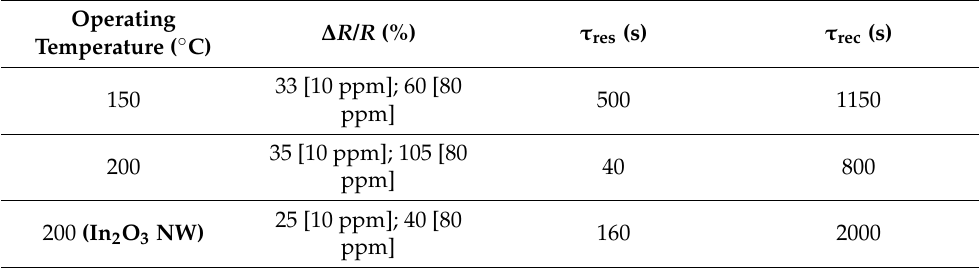
Table 2. Measured response and characteristic response and recovery times of a sensor based on a single (Ga x In 1-x ) 2 O 3 NW from Sample A, operating at temperatures of 150 and 200 ◦ C, for ethanol be- tween 10 and 80 ppm. For comparison, parameters are included from similar tests with a comparable In 2 O 3 NW sensor [4].